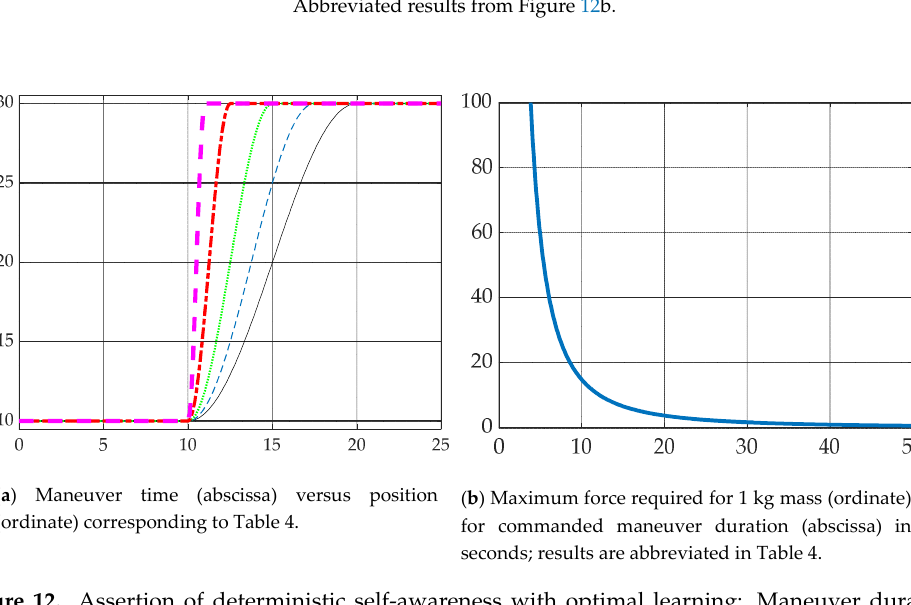
Figure 12. Assertion of deterministic self-awareness with optimal learning: Maneuver duration options and corresponding required maximum force for representative maneuver. For any given control authority provided by available motors, the selection of force in ( b ) yields ∆ t maneuver for Equations (23)–(25).